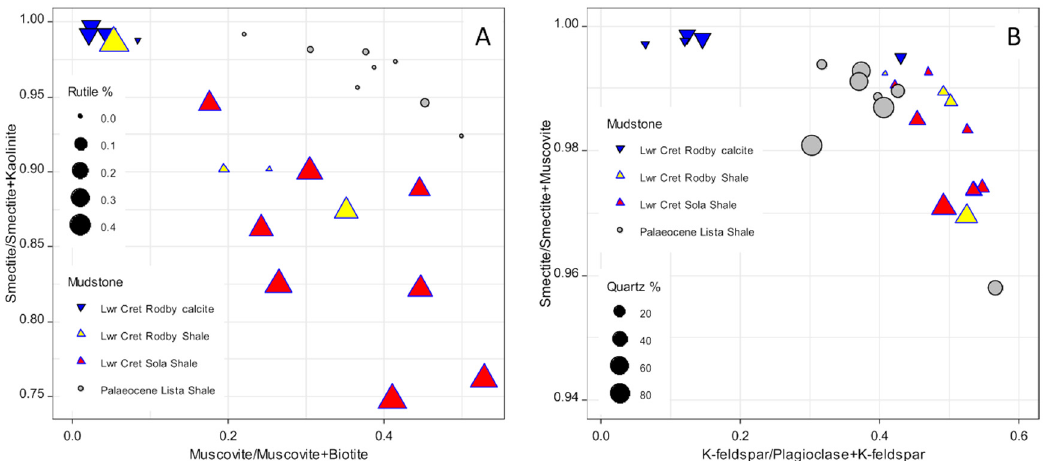
Figure 17. Comparison of SEM-EDS-derived mineralogy data for the Rodby and Lista Shales. Diagrams prepared using R-studio-ggplot2 software [15] . ( A ) muscovite/(muscovite + biotite) versus